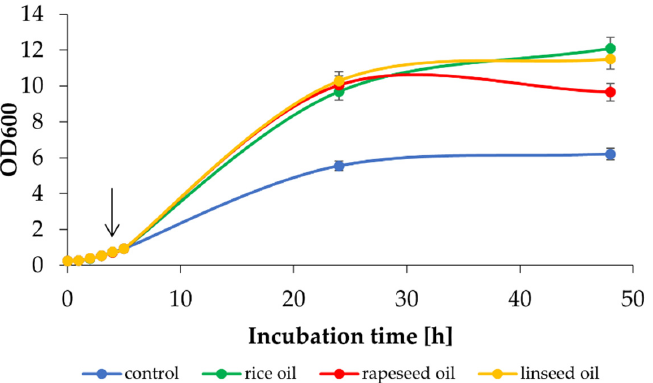
Figure 2. Effect of the presence of exogenous plant oils (20% ( v / v )) on the growth of K. marxianus WUT240 in comparison with a control culture without addition of organic phase. Cells were grown in medium WP25 with an initial OD600 = 0.15. The second phase (rice oil, linseed oil or rapeseed oil) was added at OD600 of approx. 0.8–1.0 (indicated by an arrow).